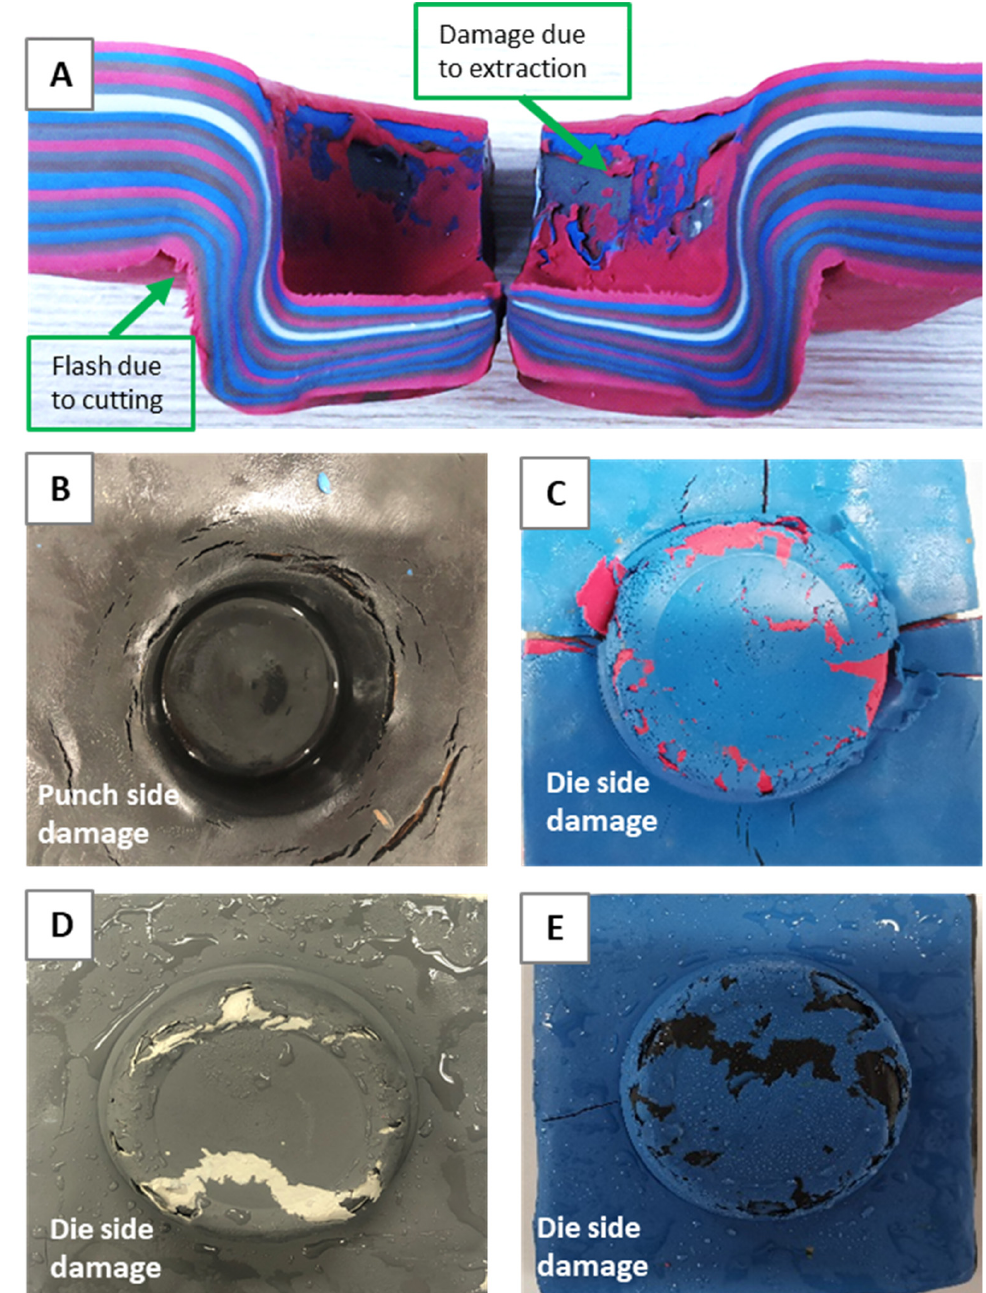
Figure 7. Preliminary results for plasticine clinched joints: ( A ) damage due to extraction and flash due to cutting; ( B , C ) damage caused by the use of silicon oil to lubricate the upper and lower sheets; ( D ) damage due to excessively cooling the sample; ( E ) damage due to preheating the slabs.